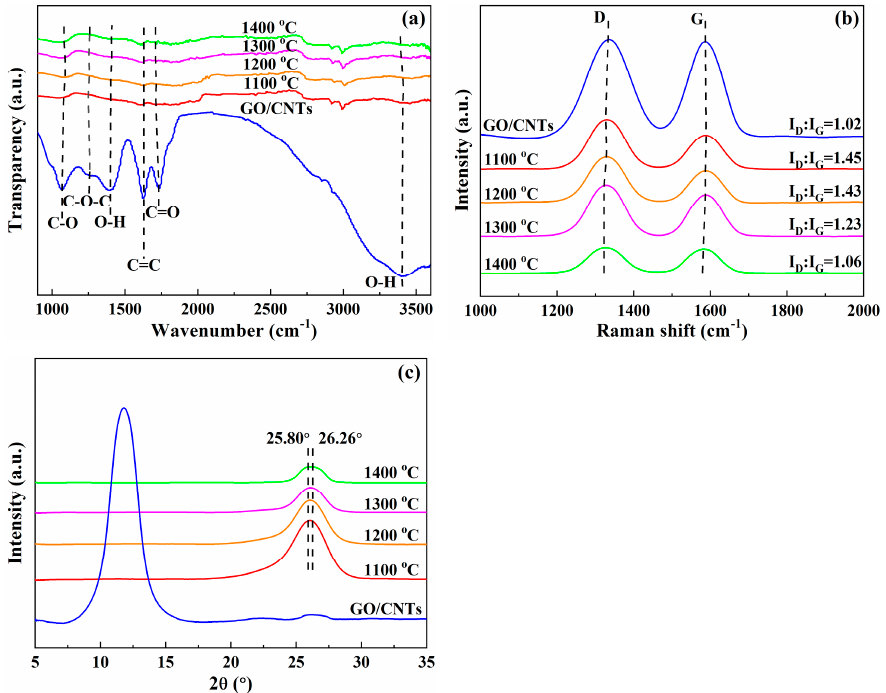
Figure 3. ( a ) FT-IR spectra; ( b ) Raman spectral evolution of D and G bands; and ( c ) XRD patterns of rGO/CNT composite films with different annealing temperatures. Table 1. Interlayer spacing of the rGO/CNT composite films with different annealing temperatures.